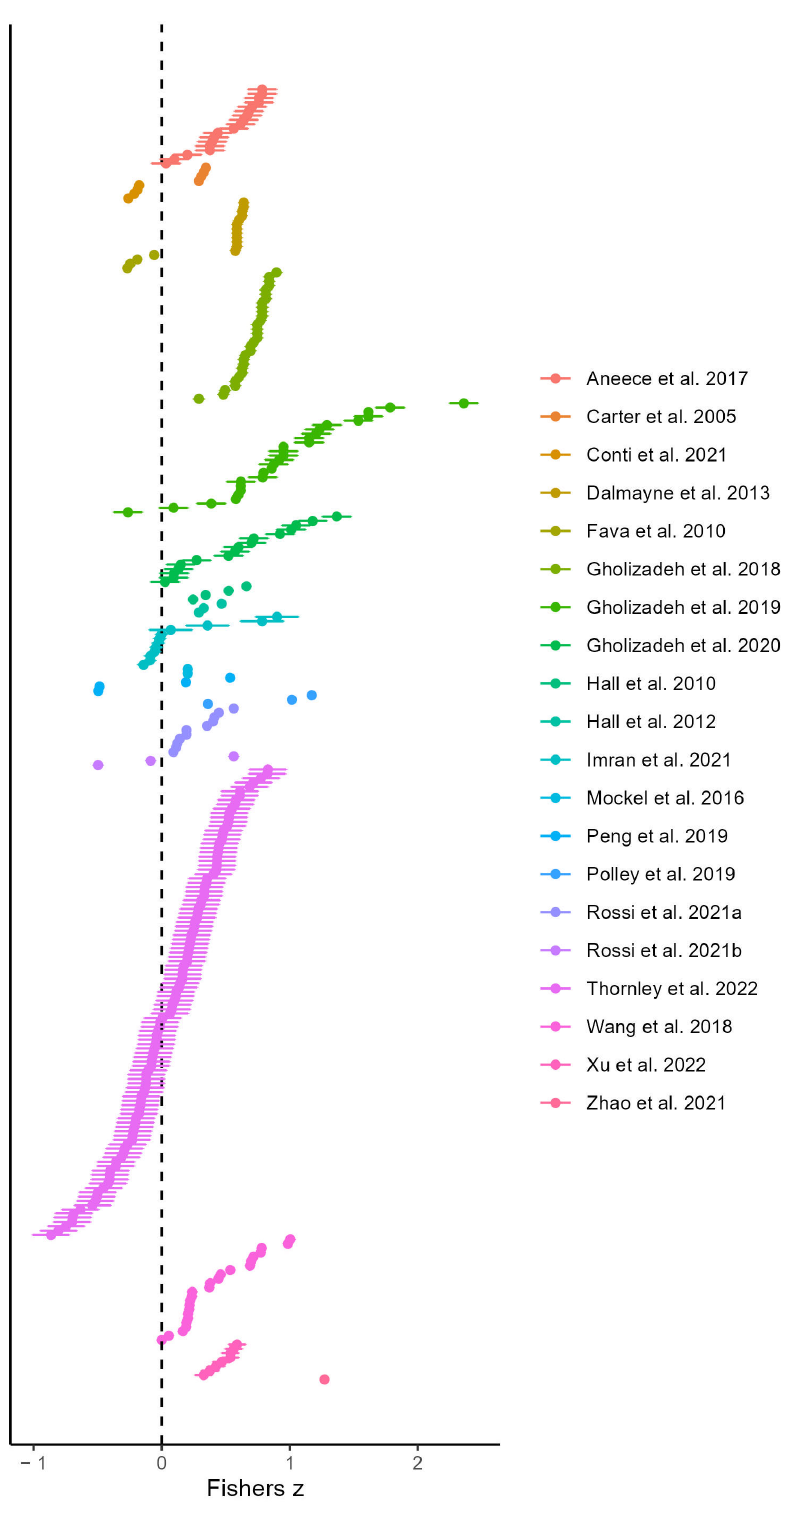
Figure 2. Forest plot showing the 297 effect sizes and their sampling variance ordered alphabetically by study. The dashed line represents the null hypothesis of no effect.